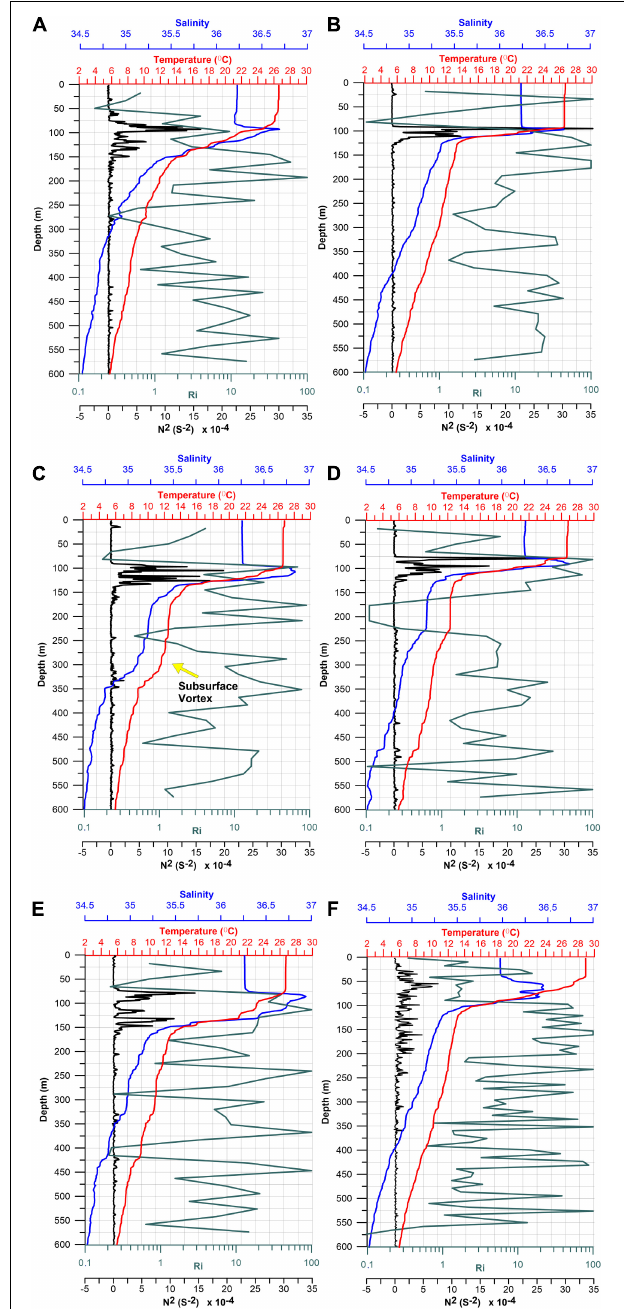
FIGURE 7 | Typical profiles of temperature, salinity, Brunt-Väisälä frequency (N) and Richardson number (Ri) for stations 5 (A) , 9 (B) , 12 (C) , 20 (D) , and 22 (E) during spring 2015 and for stations 46 (F) during fall 2017.